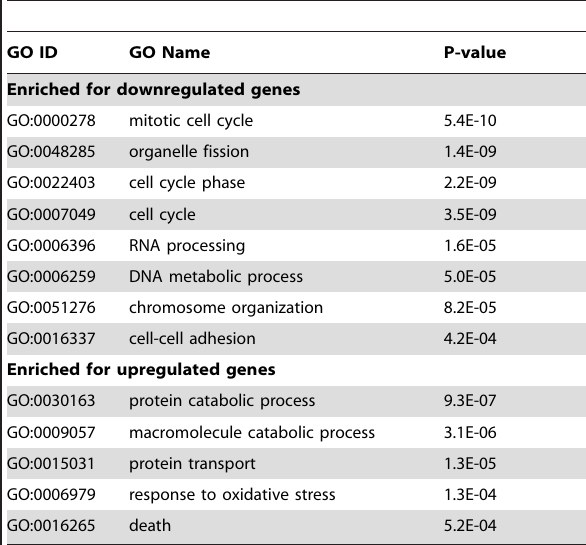
Table 1. Gene Ontology terms enriched for genes with regulated 3 9 UTRs after CstF-77 knockdown.